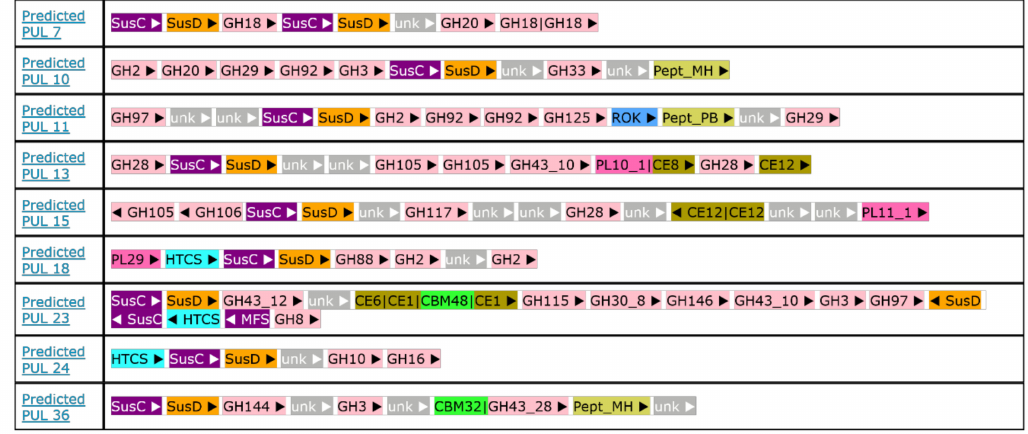
Figure 6. Polysaccharide utilization loci (PULs) of the Flavobacterium sp. SLB02 genome that have homologous PULs in the Flavobacterium johnsoniae UW101